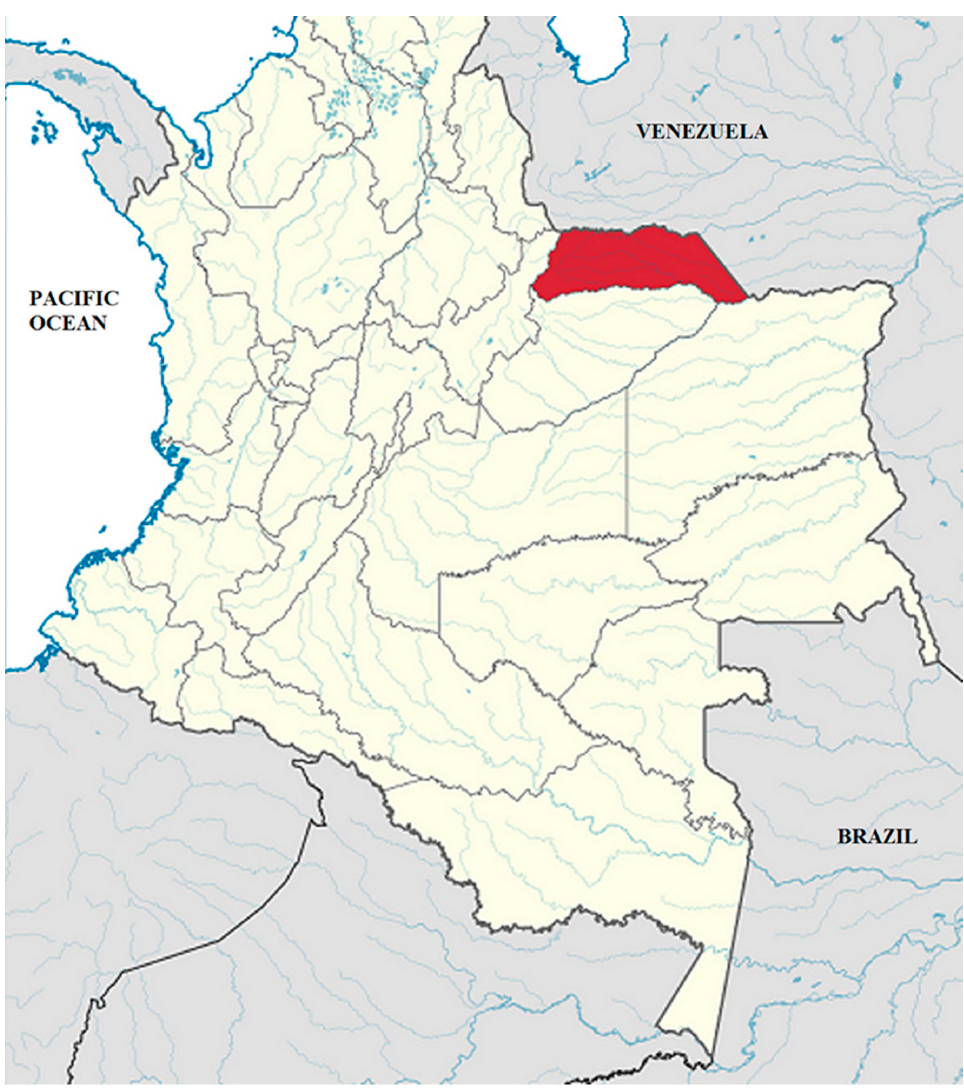
Figure 1. Arauca department located in the “Llanos Orientales” of Colombia.